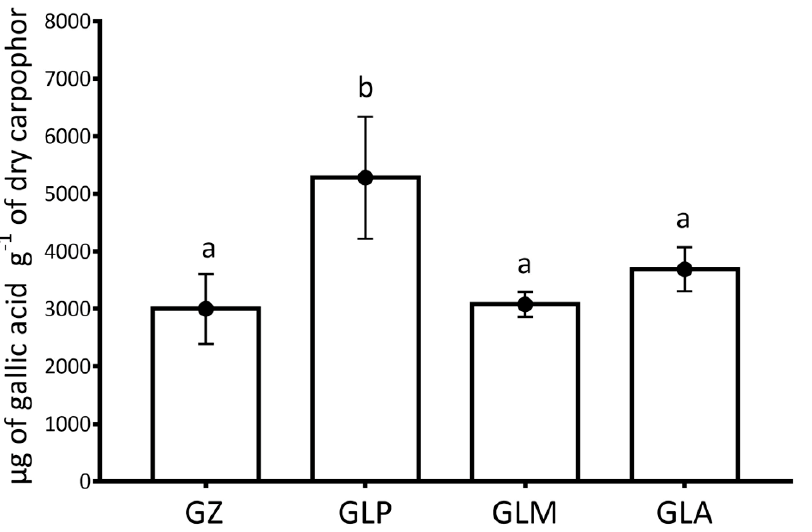
Figure 3. Total phenol content measured in the different carpophores of GL and GZ of the study using the Folin-Ciocalteu method. Different letters indicate significant differences ( p < 0.05). GZ: GZ from Shenzhen, China. GLA: GL from Aveiro, Portugal. GLM: GL from Madrid, Spain. GLP: GL from Palencia, Spain.